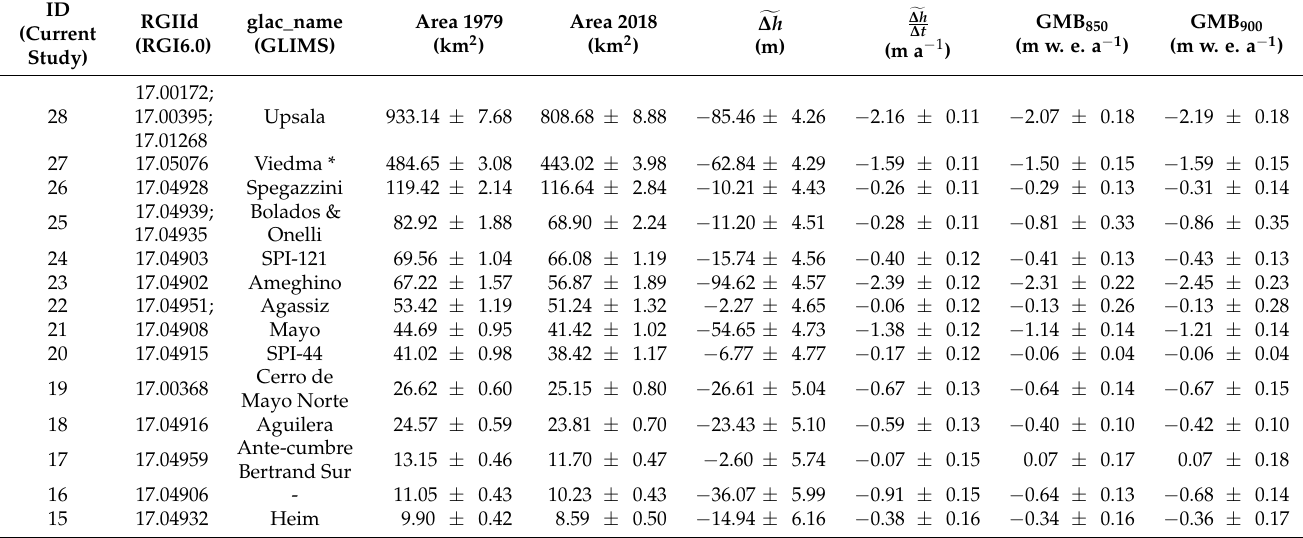
Table 9. Median glacier elevation change and geodetic mass balance 1979–2018 period for various SPI glaciers. For a better understanding and comparison, all glaciers, except the Viedma glacier, were also named considering the RGI 6.0 ID and the names in GLIMS database.